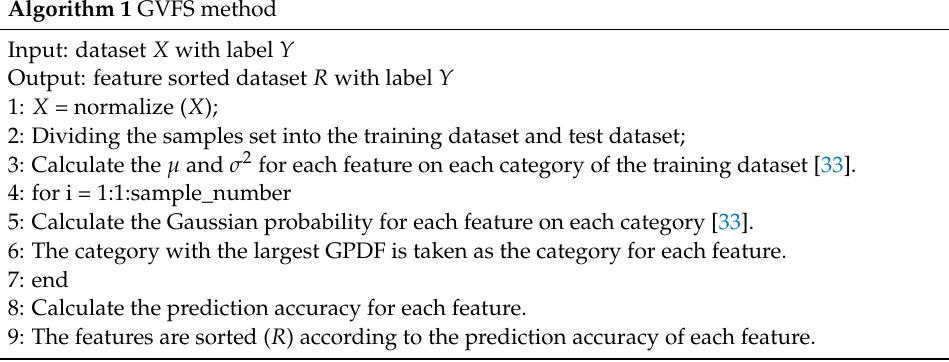
Algorithm 1 GVFS method